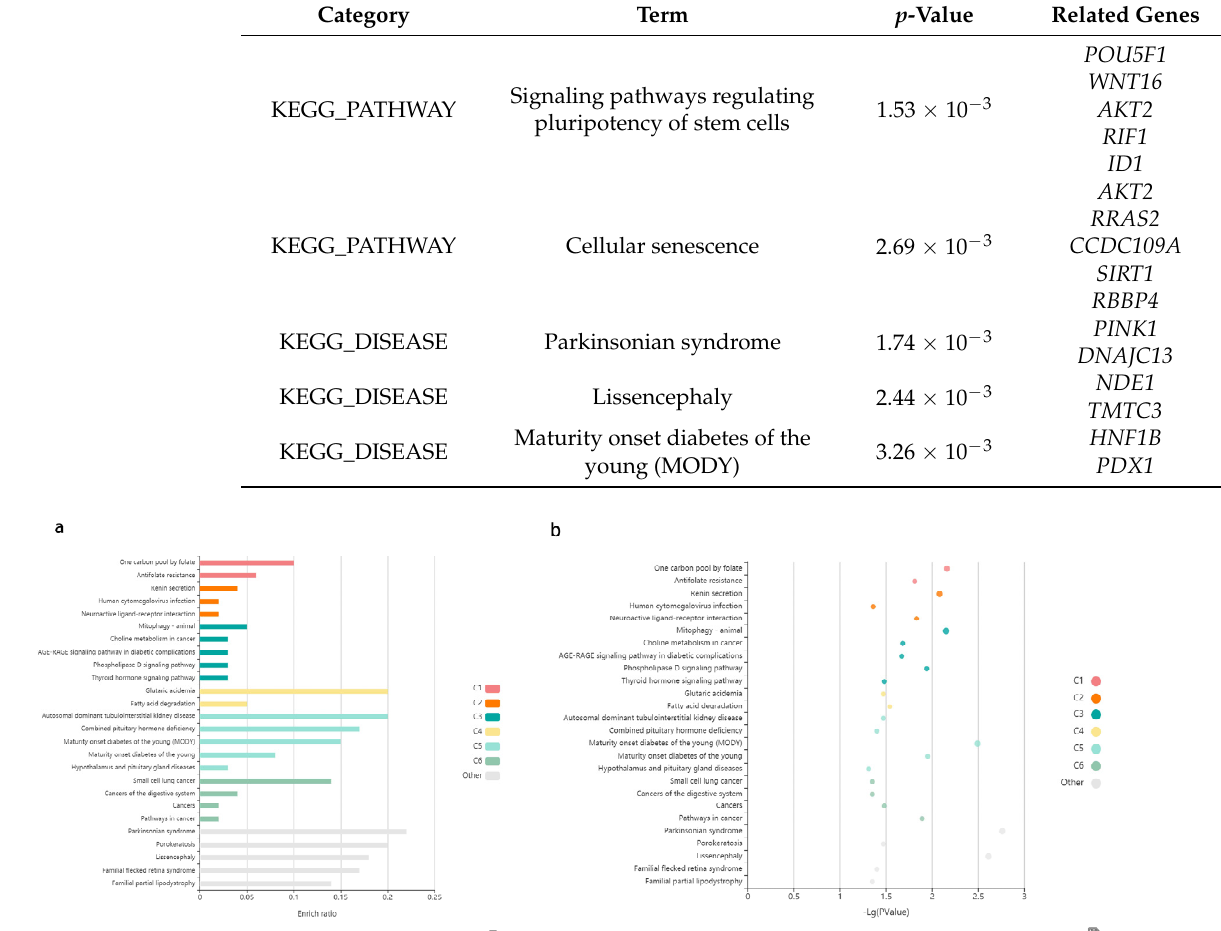
Table 2. The KEGG enrichment results of differentially methylated genes related to aging (based on SIMPO algorithm).